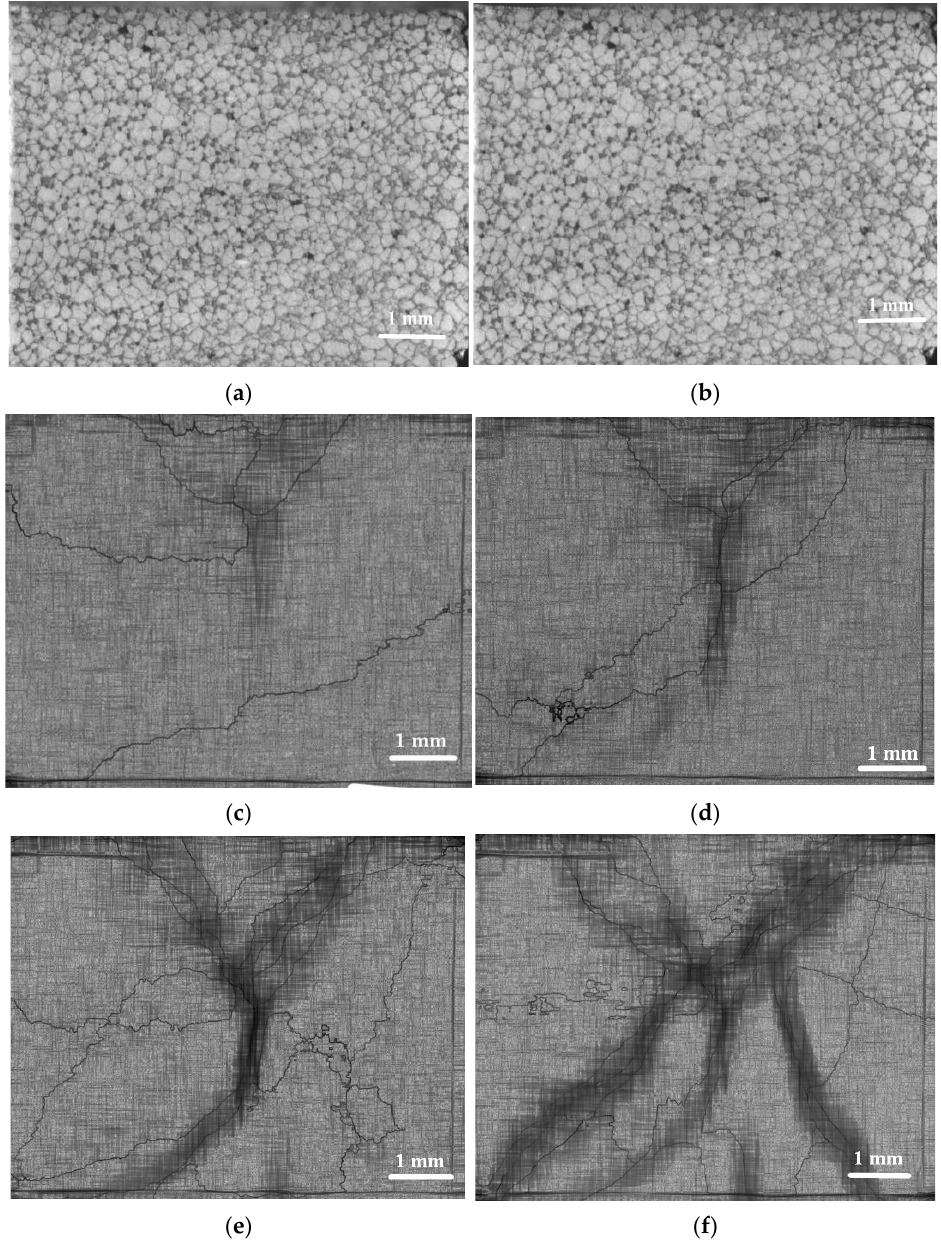
Figure 5. Optical macrographs ( a , b ) and deformation maps ( c-f ) of Sample #1 at the deformation Stage I at strain are as follows: ε = 0.000 ( a ), ε = 0.030 ( b ), ε = 0.018, ∆ ε = 0.010 ( c ), ε = 0.021, ∆ ε = 0.010 ( d ), ε = 0.027, ∆ ε = 0.010 ( e ), and ε = 0.030, ∆ ε = 0.010 ( f